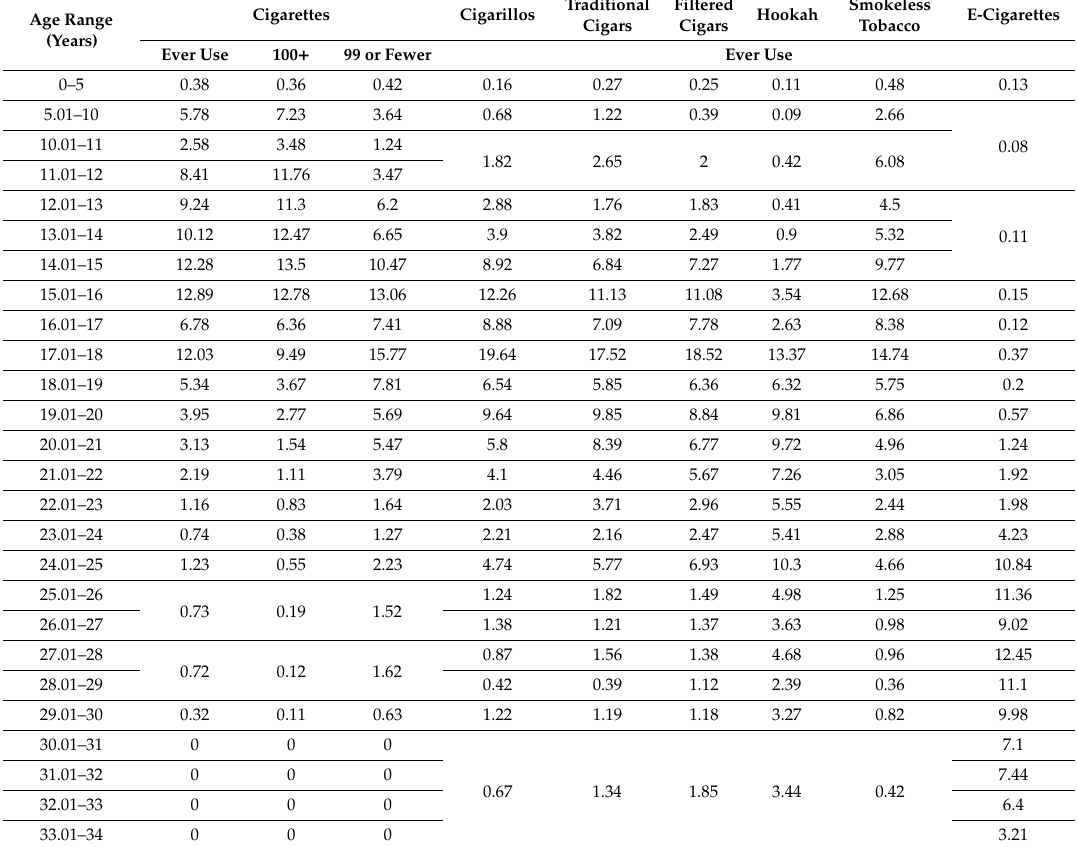
Table 2. Weighted percentages of the recalled age of initiation of multiple tobacco products among 26–34-year-old adults 2013–2014 PATH a (wave 1).